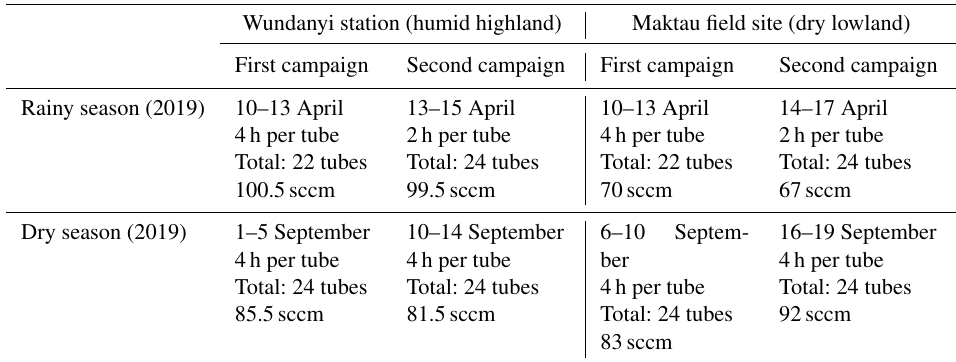
Table A1. Sample and flow rate measurements at the Wundanyi station and Maktau field site during the rainy and dry season (sccm – standard cubic centimeters per